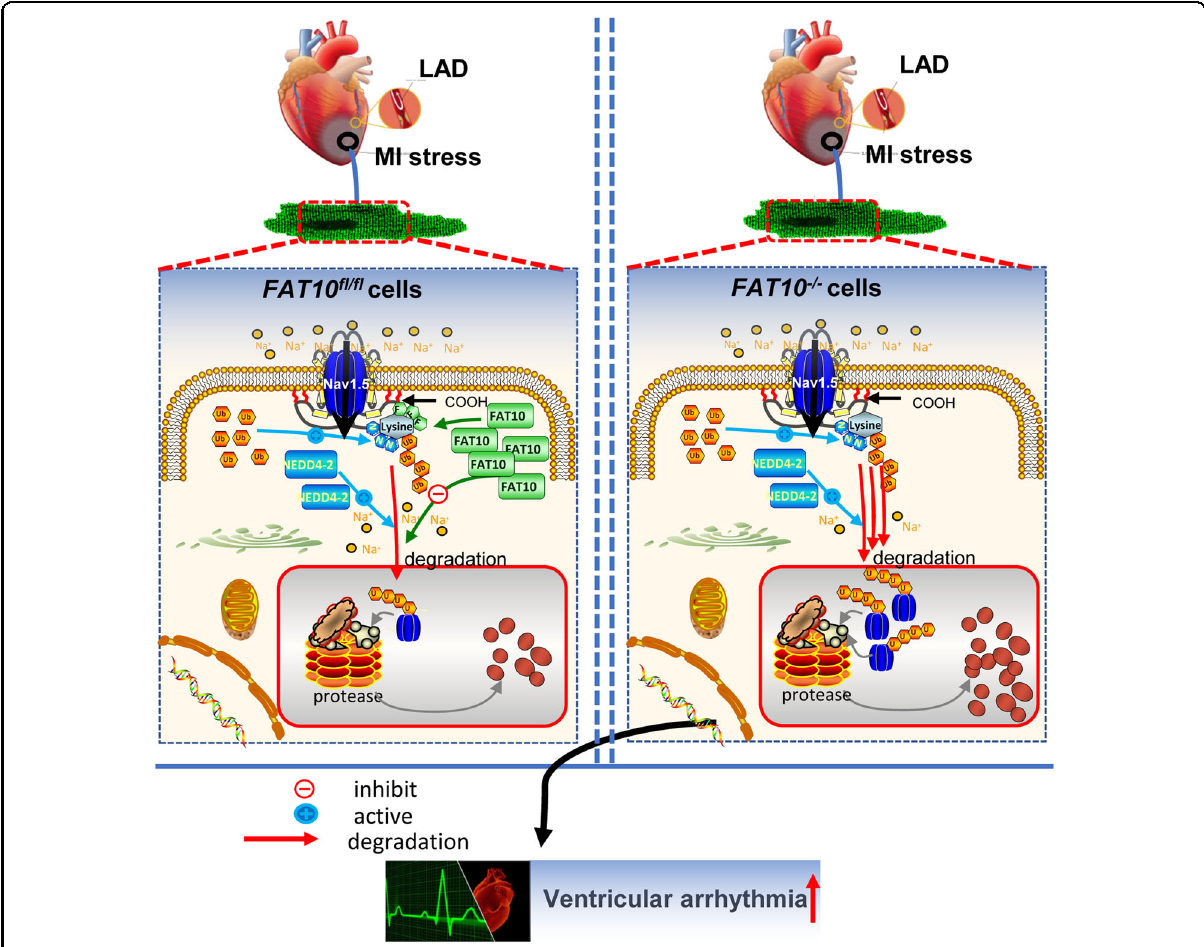
Fig. 7 Working diagram. The graphical diagram illustrated that FAT10 protected against ischemia-induced ventricular arrhythmia by decreasing Nedd4-2 – Nav1.5 complex